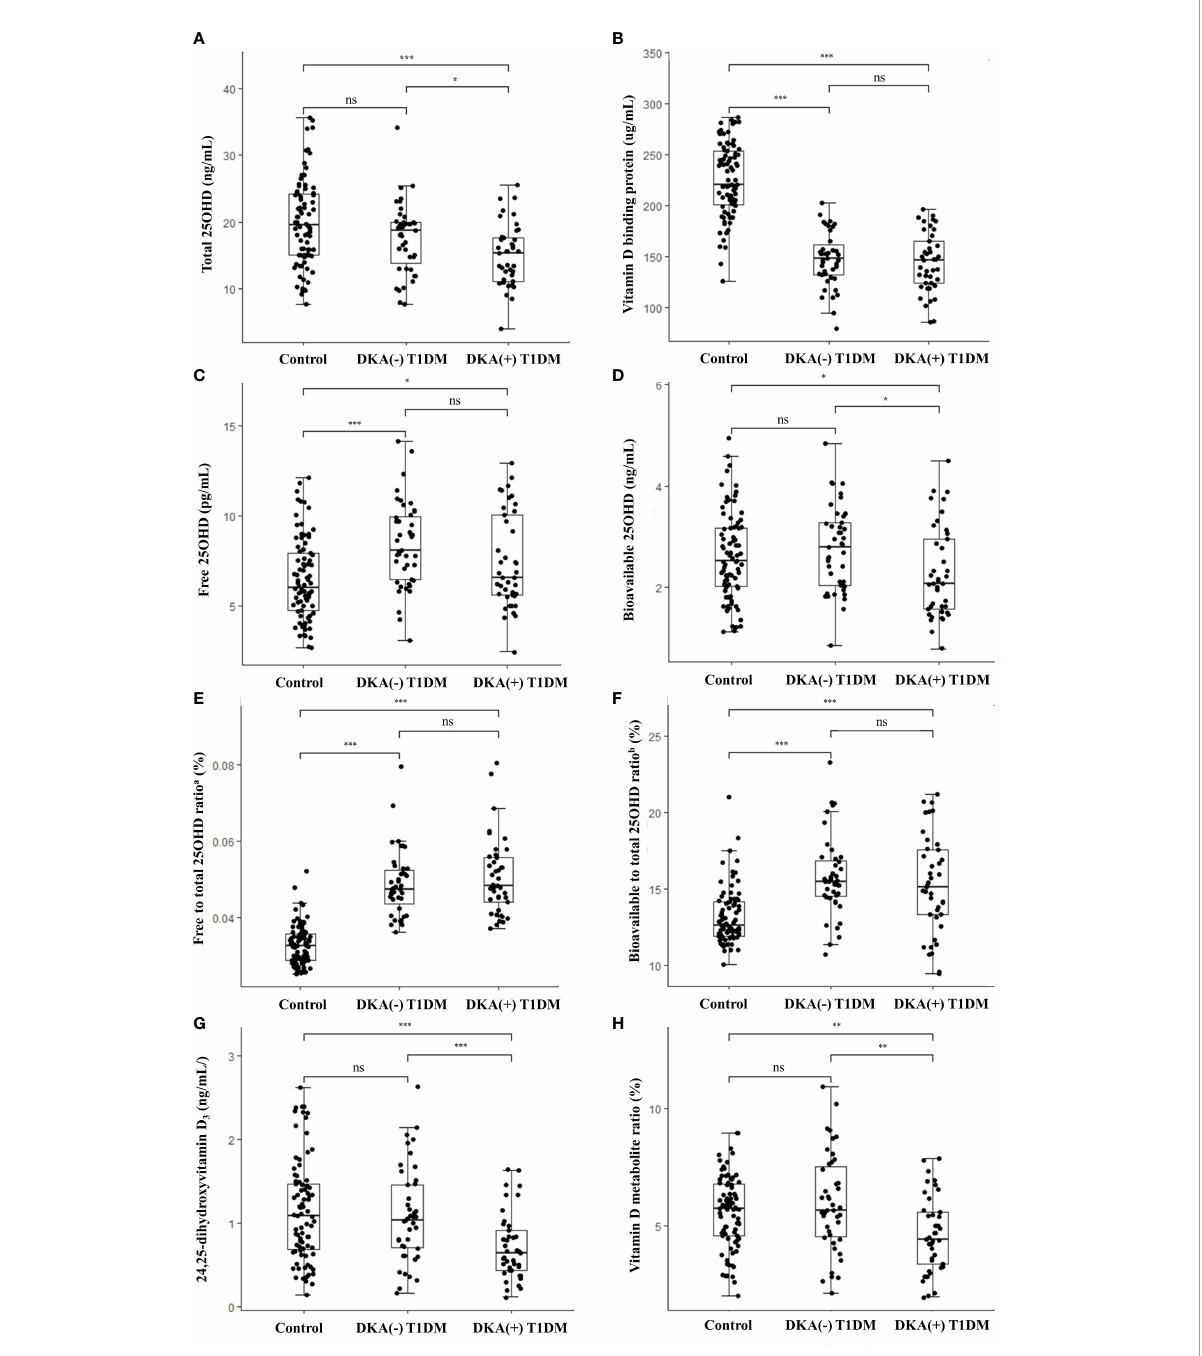
FIGURE 1 Vitamin D metabolite levels in the study population. Box-and-whisker plots of the concentrations of (A) total 25OHD, (B) vitamin D binding protein, (C) free 25OHD, (D) bioavailable 25OHD, (E) free to total 25OHD ratio, (F) bioavailable to total 25OHD ratio, (G) 24,25-dihydroxyvitamin D 3 , and (H) vitamin D metabolite ratio. Comparisons among three groups were conducted with Kruskal-wallis test for non-parametric and one- way analysis of variance (ANOVA) or Welch ’ s ANOVA for parametric variables with homogeneous or heterogeneous variances. The thick lines in the boxes indicate the medians and the whiskers indicate the maximum and minimum values, respectively. Statistically signi fi cant differences are indicated by asterisks (* P < 0.05, ** P < 0.01, *** P < 0.001). T1DM, type 1 diabetes mellitus; DKA, diabetes ketoacidosis; 25OHD, 25-hydroxyvitamin D; ns, non-signi fi cant. a Free to total 25OHD ratio (%) = [Free 25OHD (pg/mL) x 10 -3 ]/[Total 25OHD (ng/mL)] x 100 b Bioavailable to total 25OHD ratio (%) = [Bioavailable 25OHD (ng/mL)]/[Total 25OHD (ng/mL)] x